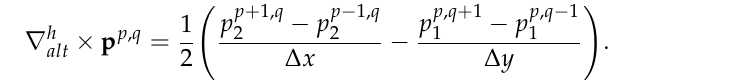
10 − 4 , α = 10 − 2 , β = 10 − 5 , × [ 0.25,0.25 ] 0.25,0.25 ] discretized over − × −